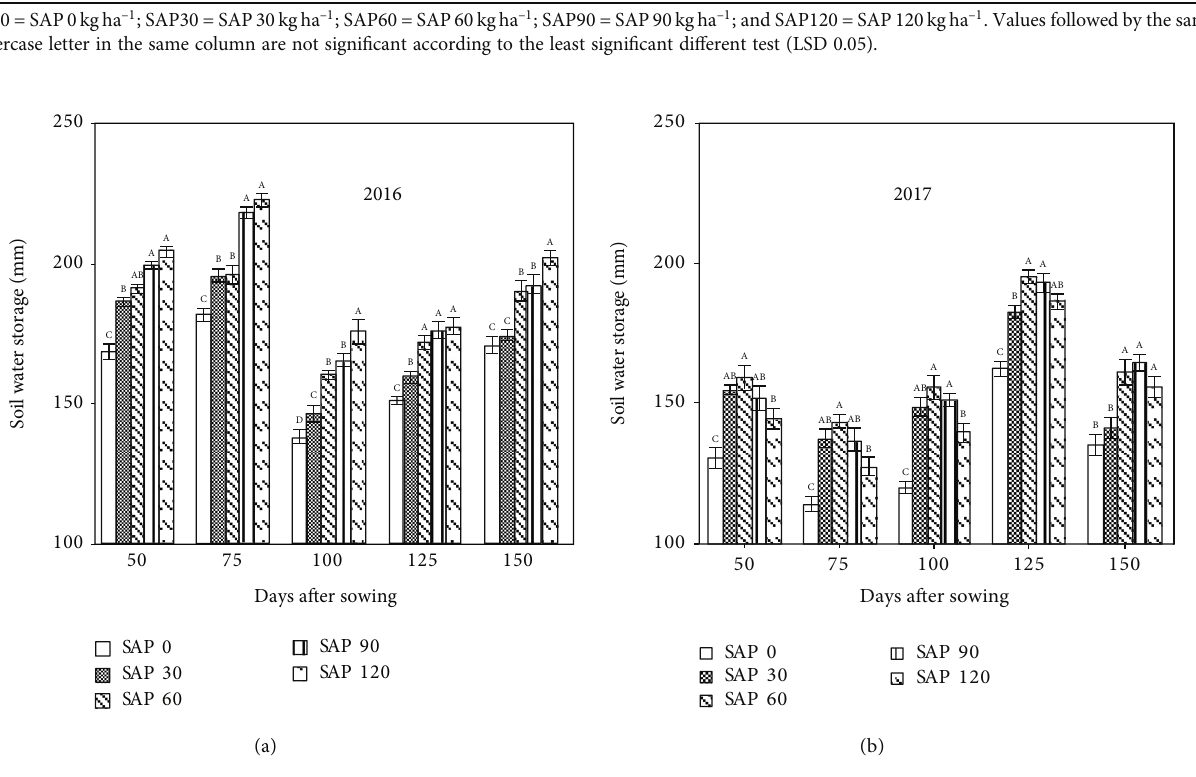
Figure 2: E ff ects of multifunctional SAP doses on soil water storage (0 – 1.0m) during the maize growing season in 2016 – 2017. SAP0 = SAP0kg ha – 1 ; SAP30 = SAP30kg ha – 1 ; SAP60 = SAP60 kg ha – 1 ; SAP90 = SAP90kg ha – 1 ; and SAP120 = SAP120 kg ha – 1 . Horizontal bars represent signi fi cant di ff erence at the 0.05 probability level according to the least signi fi cant di ff erent test (LSD 0.05).